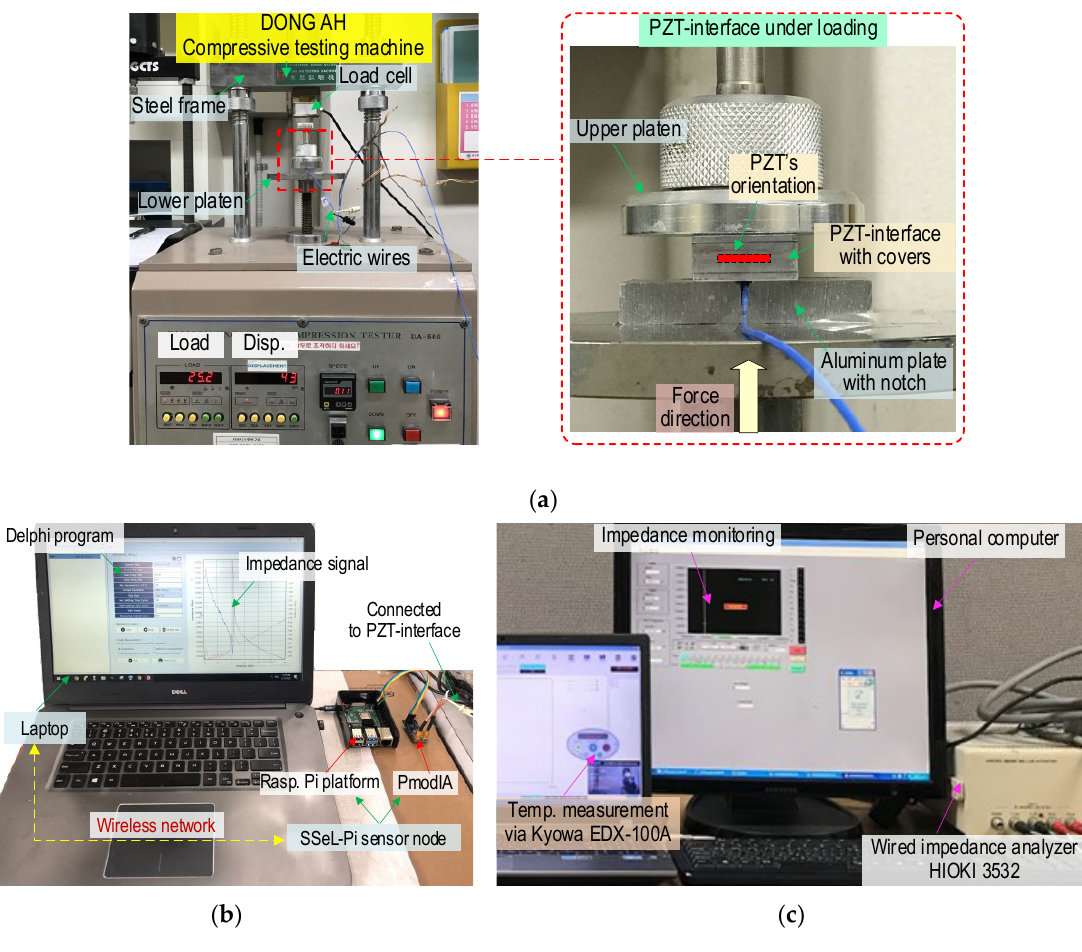
Figure 18. Impedance measurement of PZT interface device via SSeL-Pi and HIOKI-3532. ( a ) PZT interface device under compression test, ( b ) SSeL-Pi system, ( c ) HIOKI 3532 system.